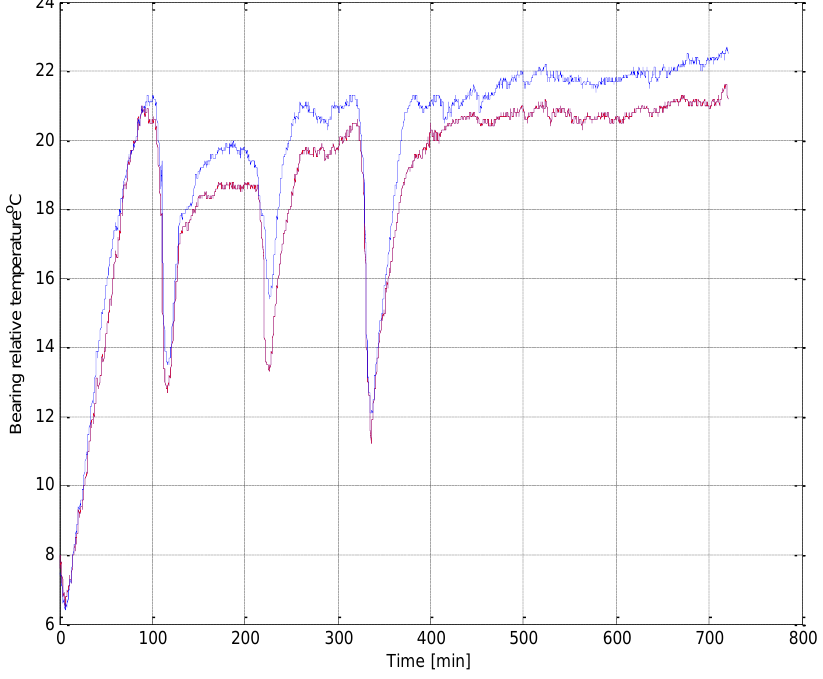
Figure 1. The changed tendency of the bearing’s relative temperature.